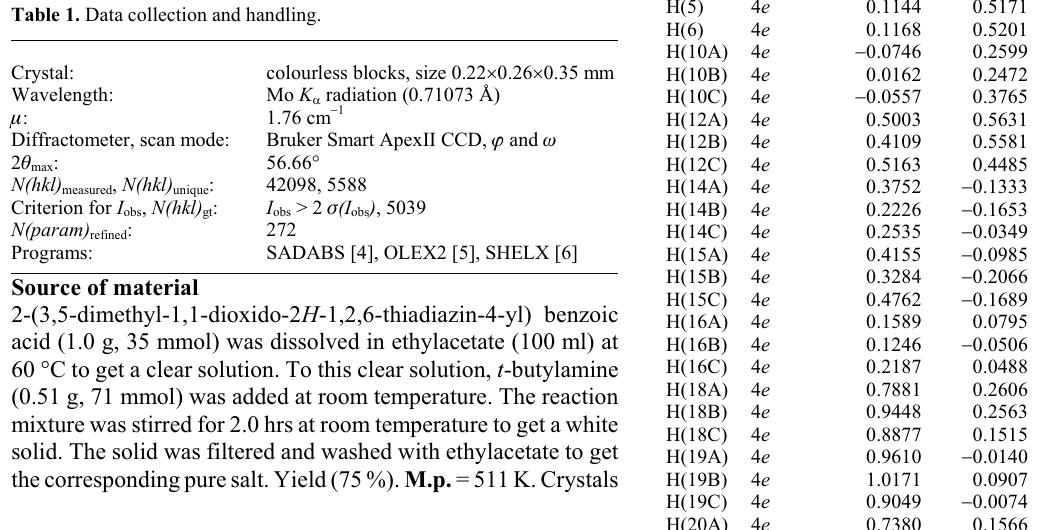
Table 1. Data collection and handling.